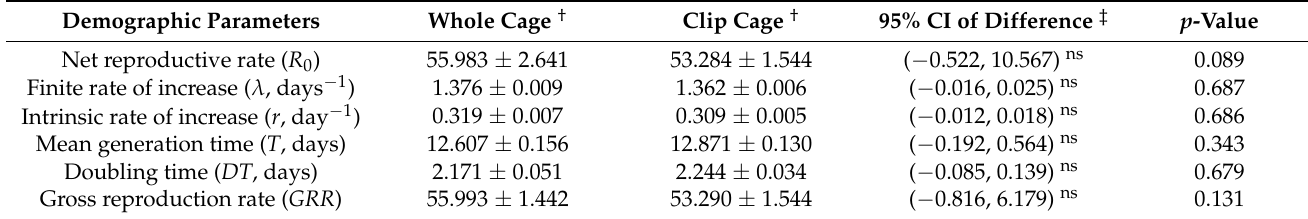
Table 2. Demographic parameters of Sitobion avenae confined to clip cages and whole